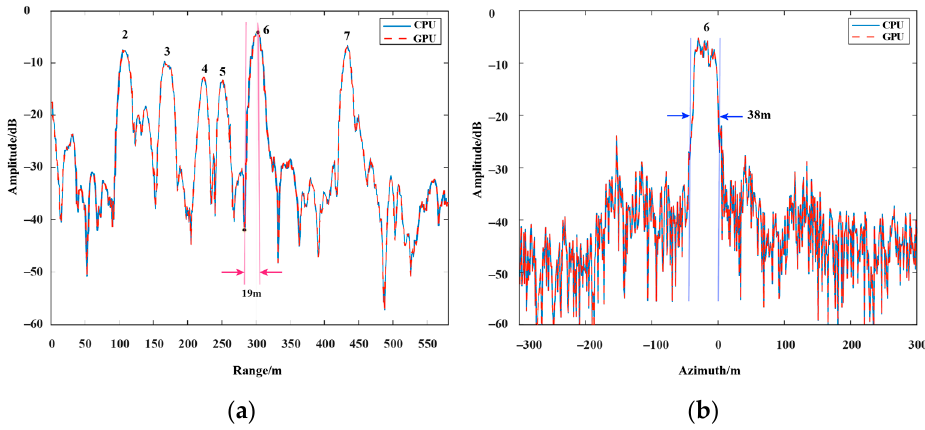
Figure 11. Cross-sections for Target No.6, ( a ) is range profile, and ( b ) is azimuth